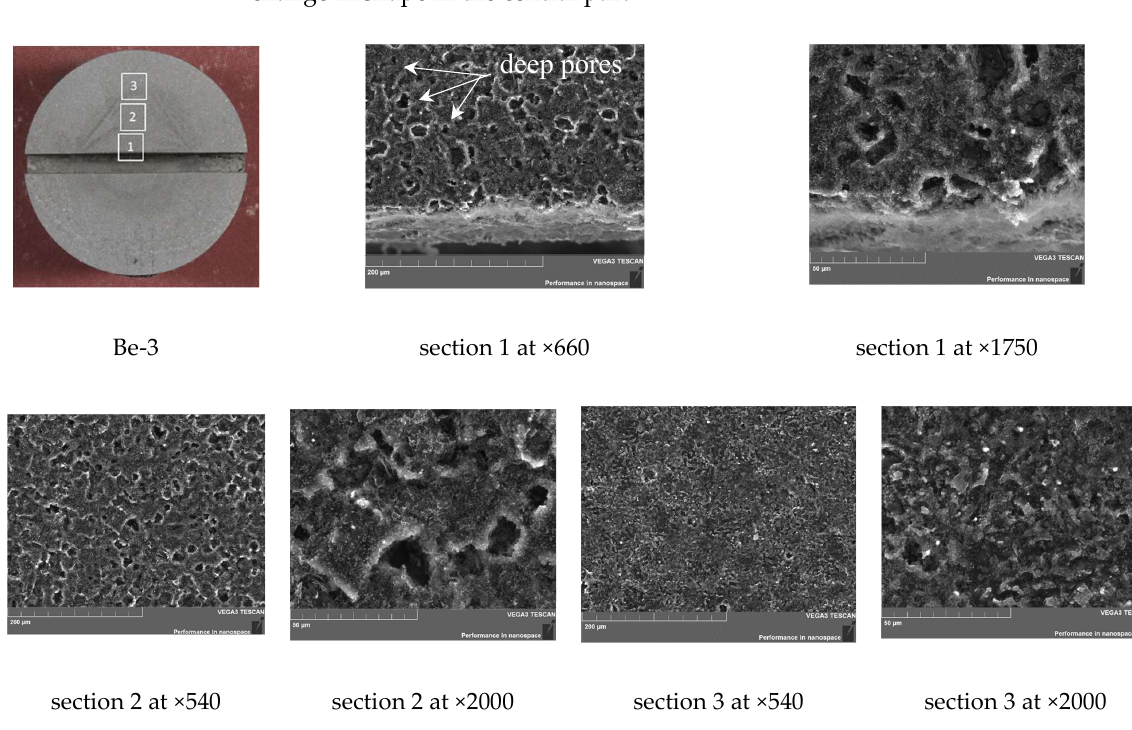
Figure 13. SEM image of the sample Be-3 surface (1200 °С, 10 cycles). Sample Be-6 was subjected to change in shape not only due to plasma effect, but also to deformation during the test. Under plasma exposure, sample erosion occurred on the entire surface of the sample; this included the walls and bottom of the notch (Figure 14). The surface of the right segment is more eroded than the left one.